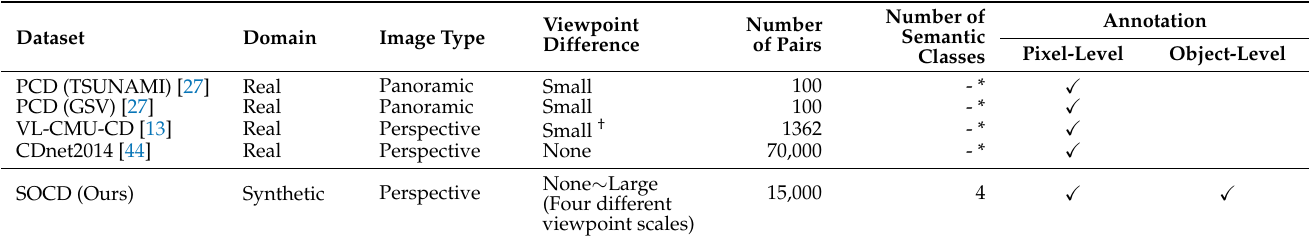
Table 1. A comparison of the existing street view change detection datasets. The Viewpoint Difference column indicates the scale of the viewpoint differences between image pairs. Notably, the SOCD dataset included four separate scales for viewpoint differences, which enabled an examination of the relationship between the scale of viewpoint differences and the accuracy of the change detection model. The Annotation columns indicate each the annotation type that was used in each dataset (i.e., pixel-level annotation, such as binary change masks or semantic change masks, and object-level annotation, such as bounding boxes or instance